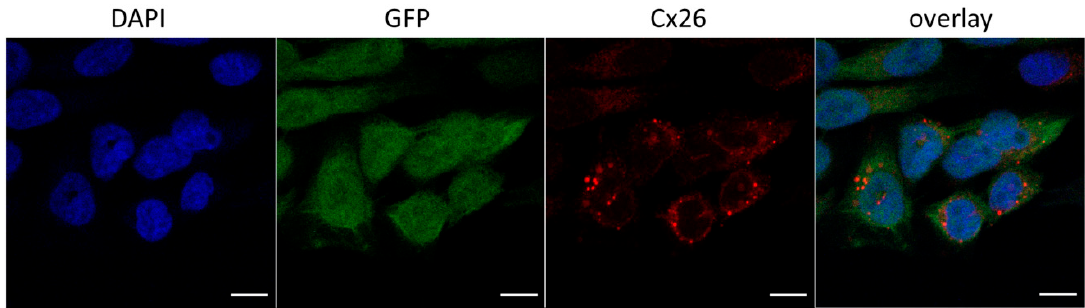
Figure 2. A fraction of HeLa-p.W172C cells with reduced number of protein granules (confocal micrographs). Blue color indicates DAPI nuclei staining, green color corresponds to GFP signal, red color corresponds to Cx26 signal. Scale bar = 10 µm.